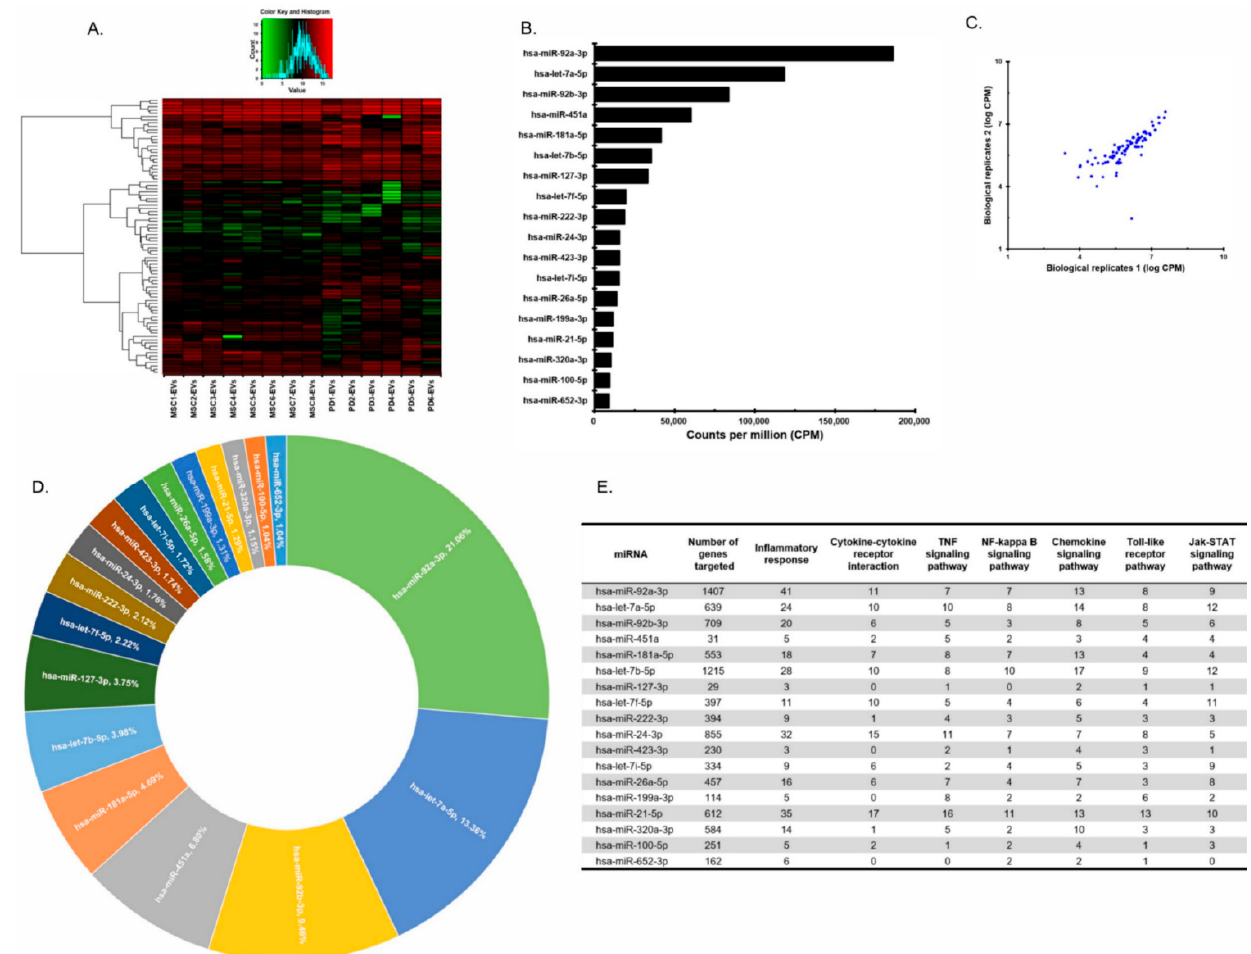
Figure 1. Profiles of miRNAs of pMSC-EVs and placental EVs. ( A ) The miRNA profiles of eight MSCs and six placenta- derived EVs (PD-EVs). ( B ) pMSC-EVs miRNAs were ranked (highest to lowest) in terms of counts per million (CPM). ( C ) A strong correlation between biological replicates. ( D ) The percentage of the top 18 miRNAs accounted for all EV miRNAs. ( E ) The total of 5380 genes that are predicted to be targeted by 18 miRNAs in a validated miRNA target database (the mirTarBase) and a breakdown of over-represented pathways and biological processes is shown.